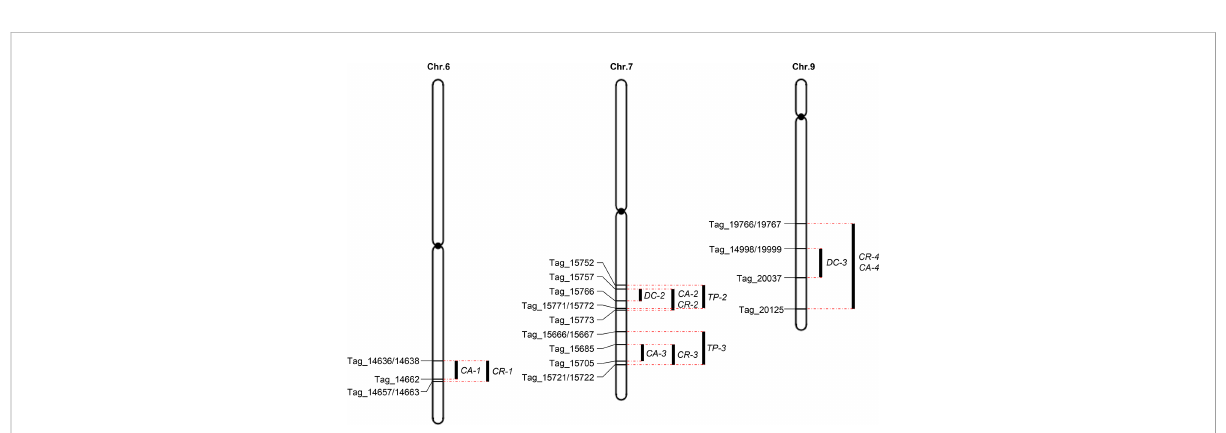
FIGURE 6 QTL clusters for rice grain quality traits. Black bars indicate QTLs identi fi ed using the composite interval mapping function in QTL Cartographer. Markers on the boundaries of QTLs are identi fi ed. Red dashed lines indicate the boundaries of overlapping